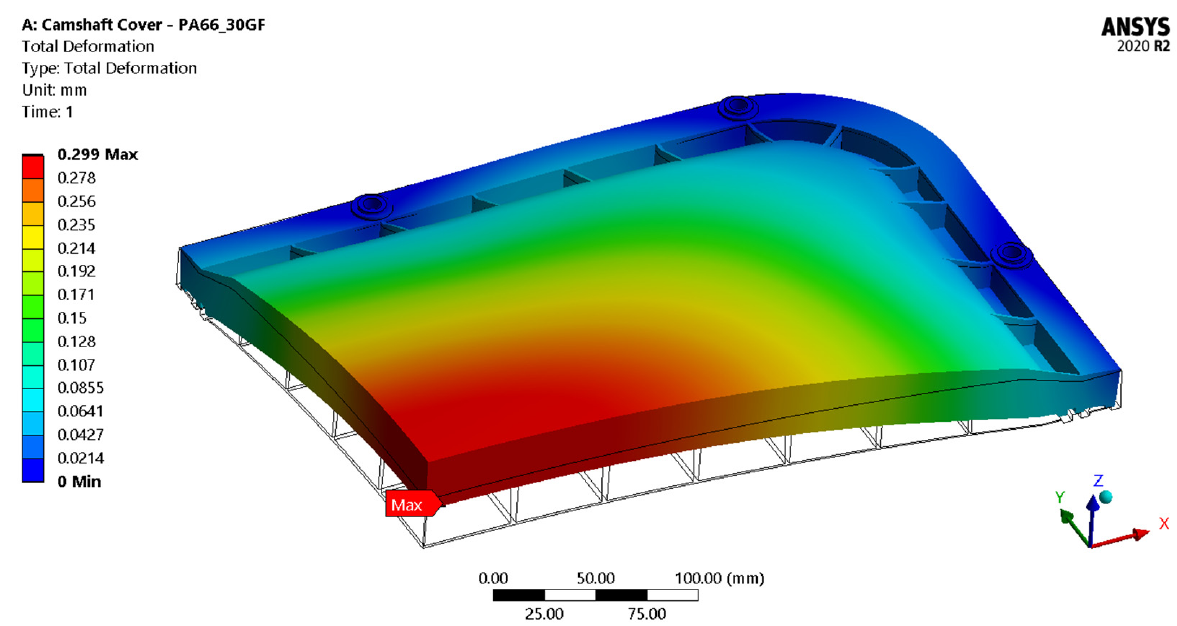
Figure 6. FEA results: total deformation.